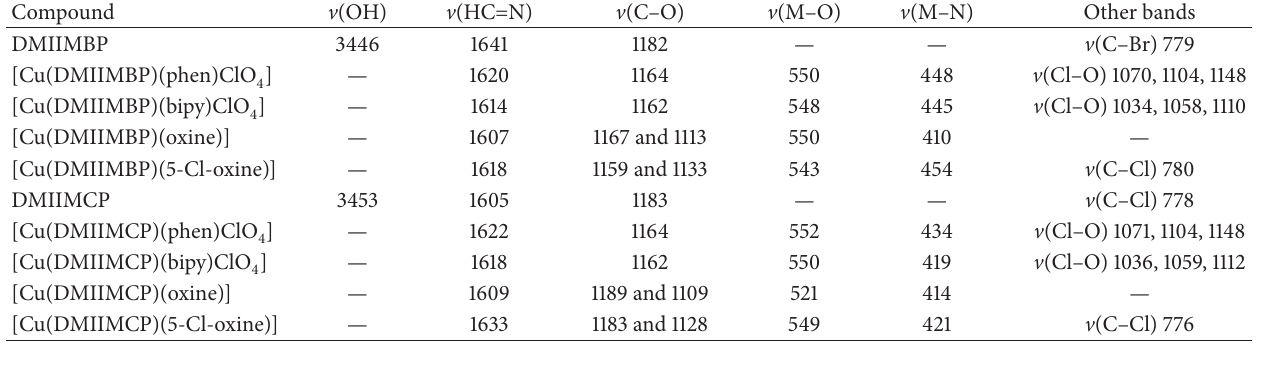
Table 2: Some important IR absorption frequencies (cm − 1 ) of Schiff bases and metal complexes.